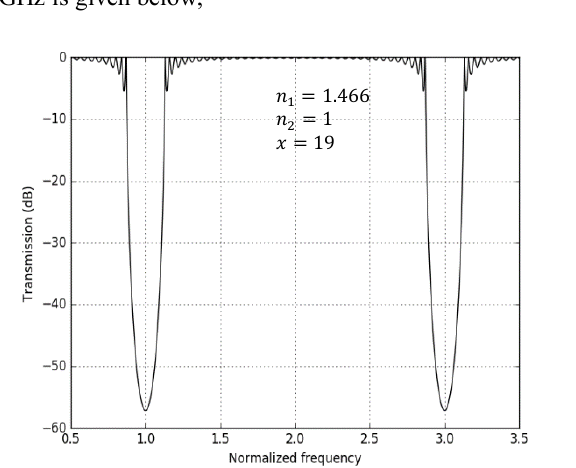
FIG. 3. Theoretical transmission spectrum of the multimode filter From the theoretical study of the